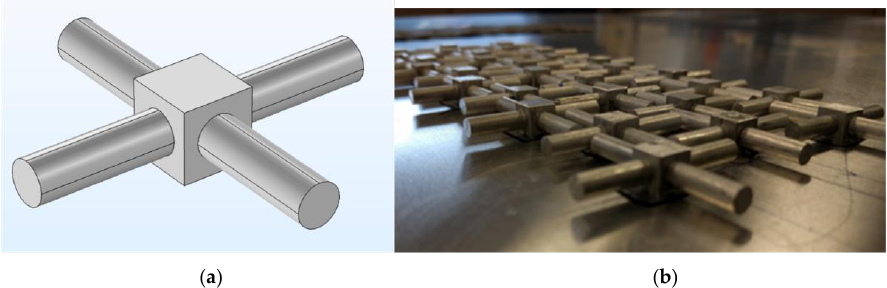
Figure 3. ( a ) Isometric view of a clamping resonator, and ( b ) the 30 clamping resonators in an array according to the spacing shown in Figure 1b.